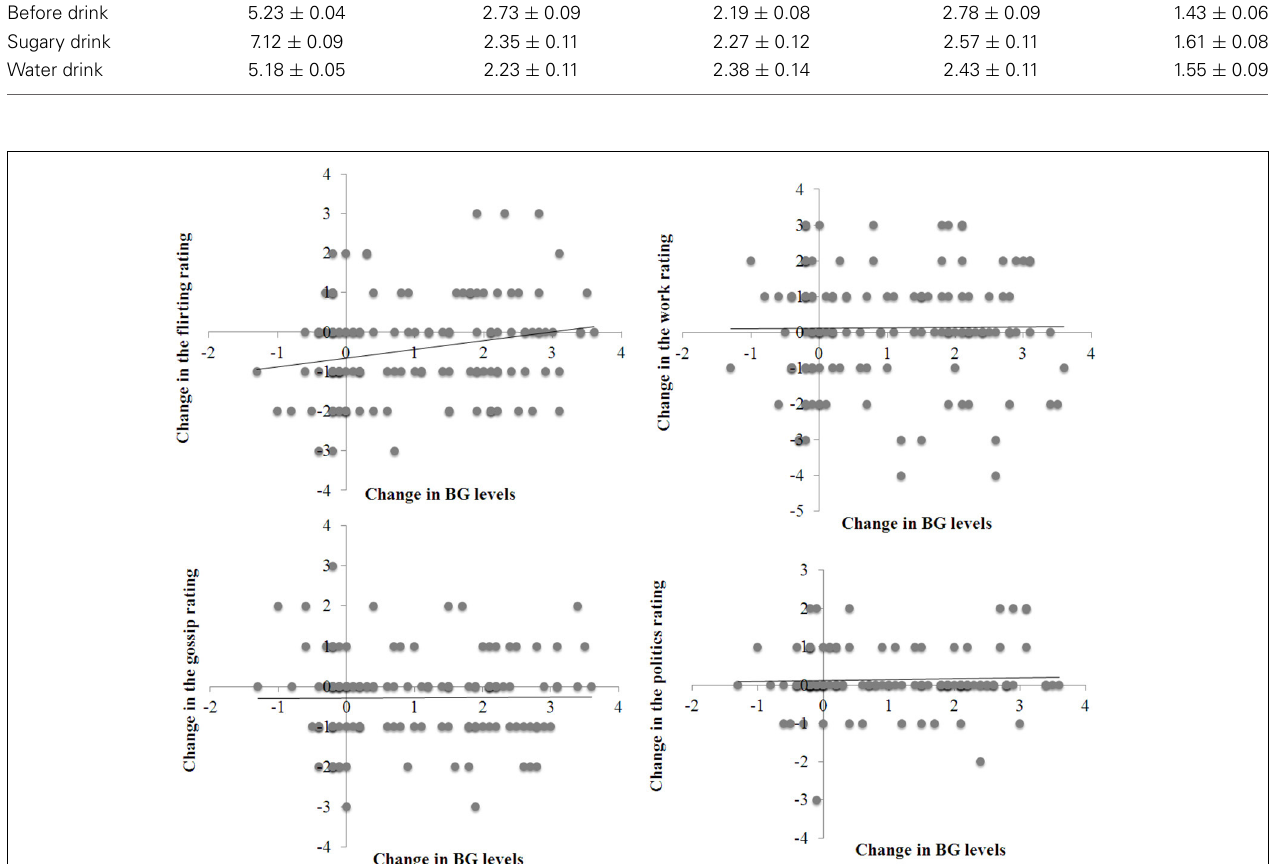
FIGURE 4 | Scatter plots of the change in four rating scores for the photos (the rating before drinking minus the rating after drinking) as a function of the change in blood glucose levels (the second BG check minus the first BG check).